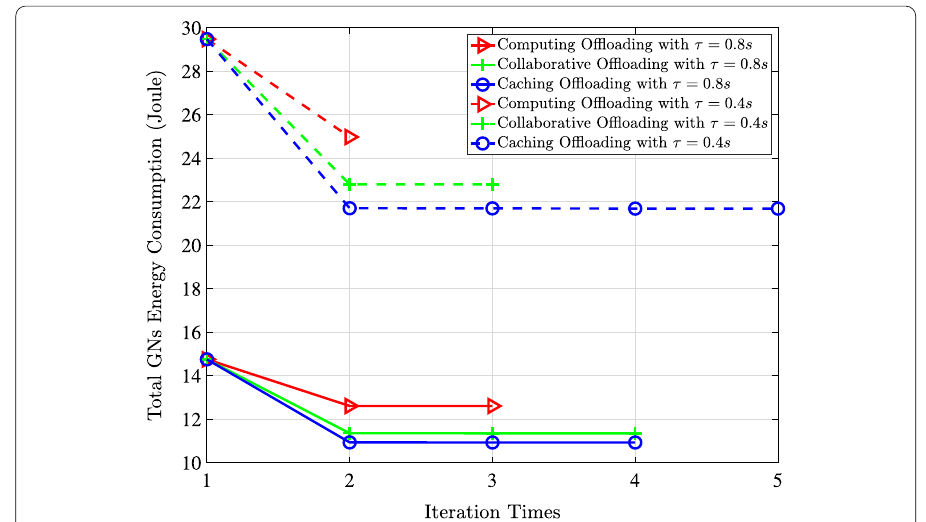
Fig. 5 The total energy consumption of GNs w.r.t. different offloading schemes when K